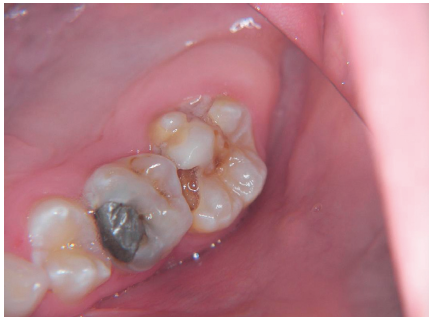
Figure 2: Severe molar hypomineralization.